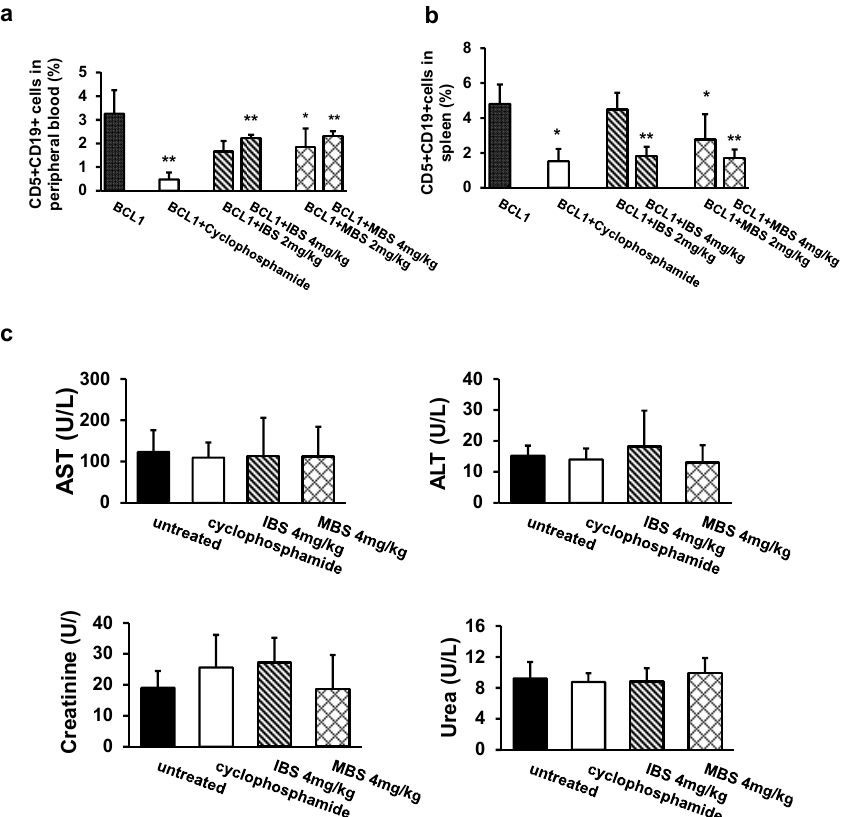
Figure 6. Treatment with IBS and MBS inhibits BCL1 leukemia growth in vivo. Mononuclear cells from ( a ) peripheral blood and ( b ) spleens of untreated and IBS- and MBS-treated mice 20 days after intravenous BCL1 cell injection (1 × 10 6 ). The percentage of CD5+CD19+ BCL1 cells is presented as the mean ± SD. * p < 0.05, ** p < 0.01. ( c ) AST, ALT, urea, and creatinin levels were determined in the serum 90 days after the BCL1 injection in untreated and IBS- and MBS-treated mice, presented as the mean ± SD (eight animals per group).